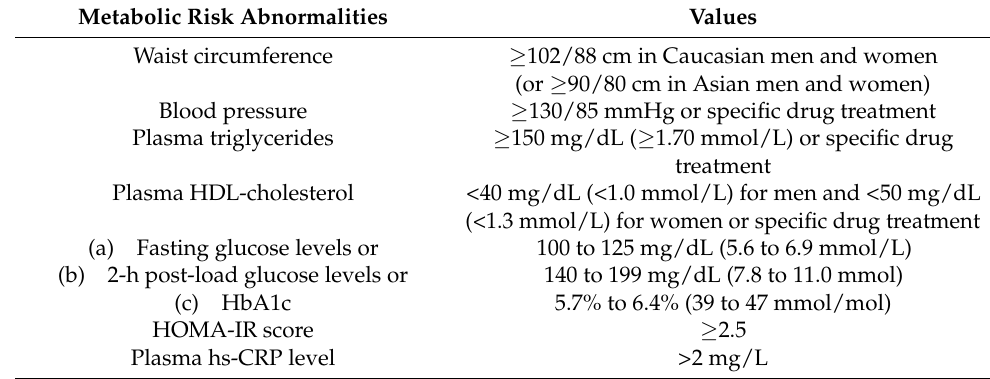
Table 1. Cardiometabolic and MAFLD risk abnormalities. Adapted from Eslam et al.